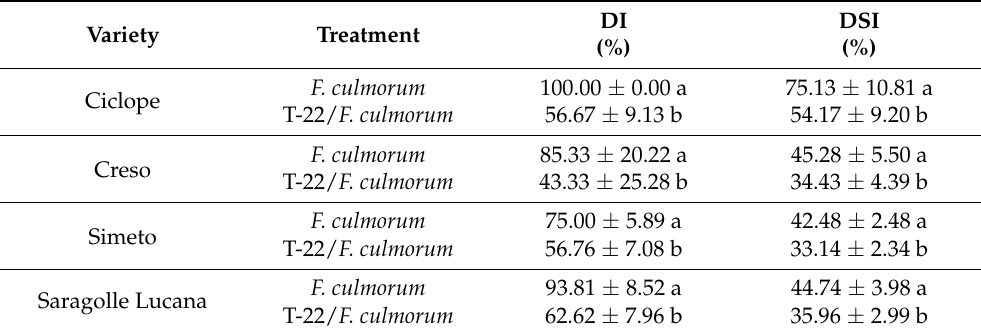
with F. culmorum , measured at 21 days after